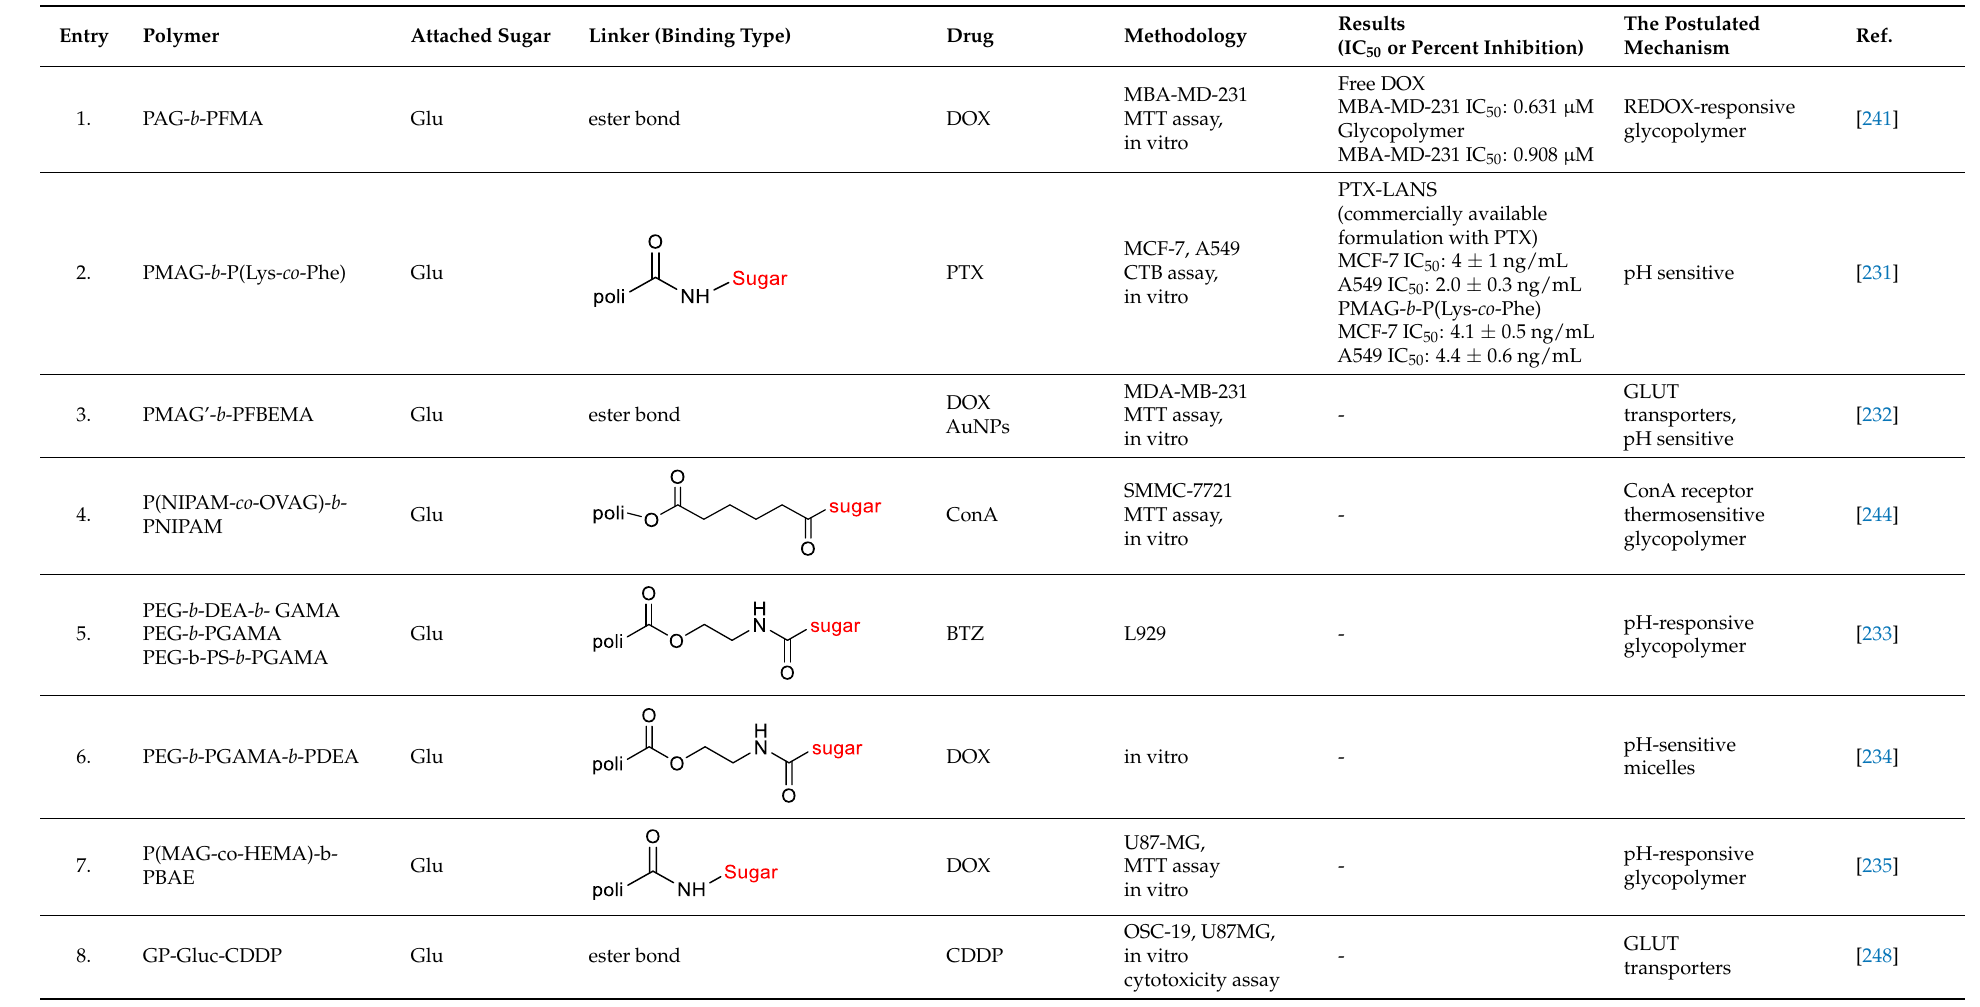
Table 4. Glycopolymer-based carriers for anticancer drugs.